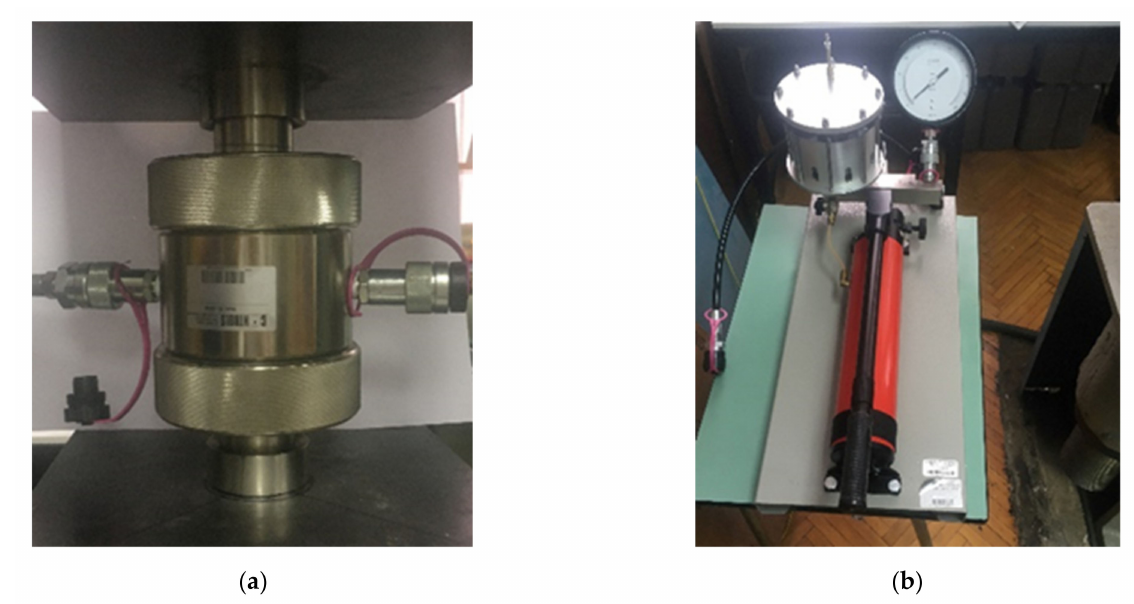
Figure 6. Triaxial test equipment: ( a ) Hoek cell and ( b ) manual confining pressure system for